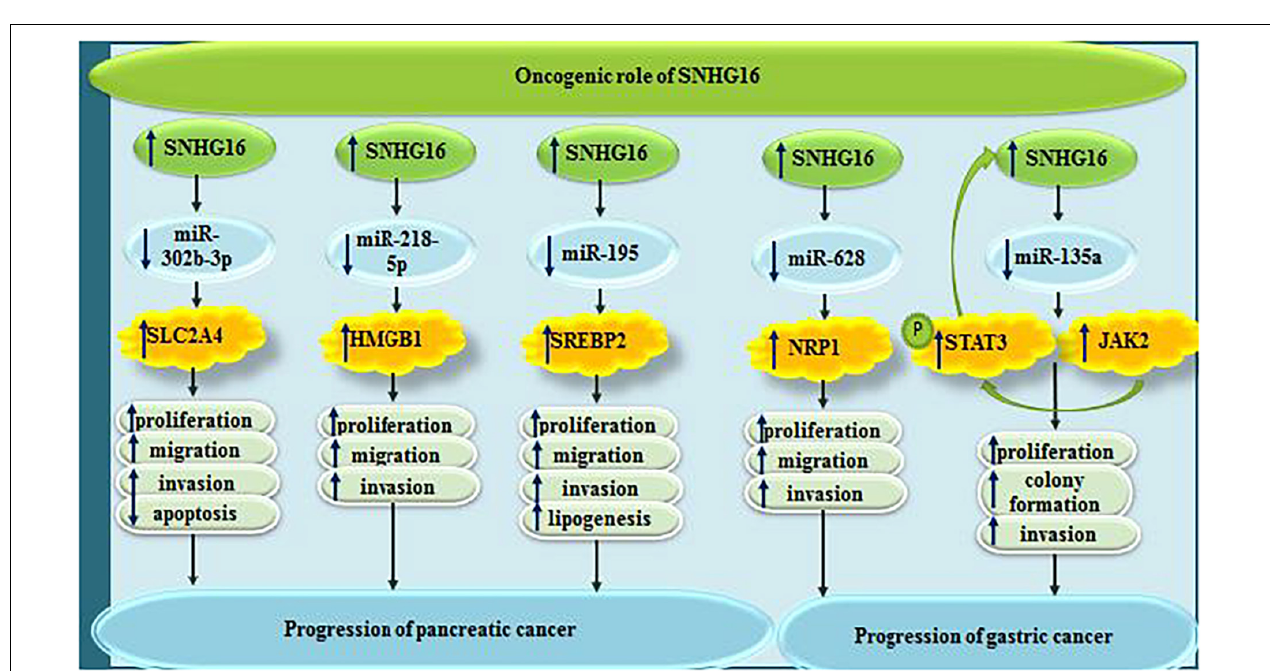
FIGURE 8 | Oncogenic roles of SNHG16 in retinoblastoma, oral squamous cell carcinoma and nasopharyngeal carcinoma.